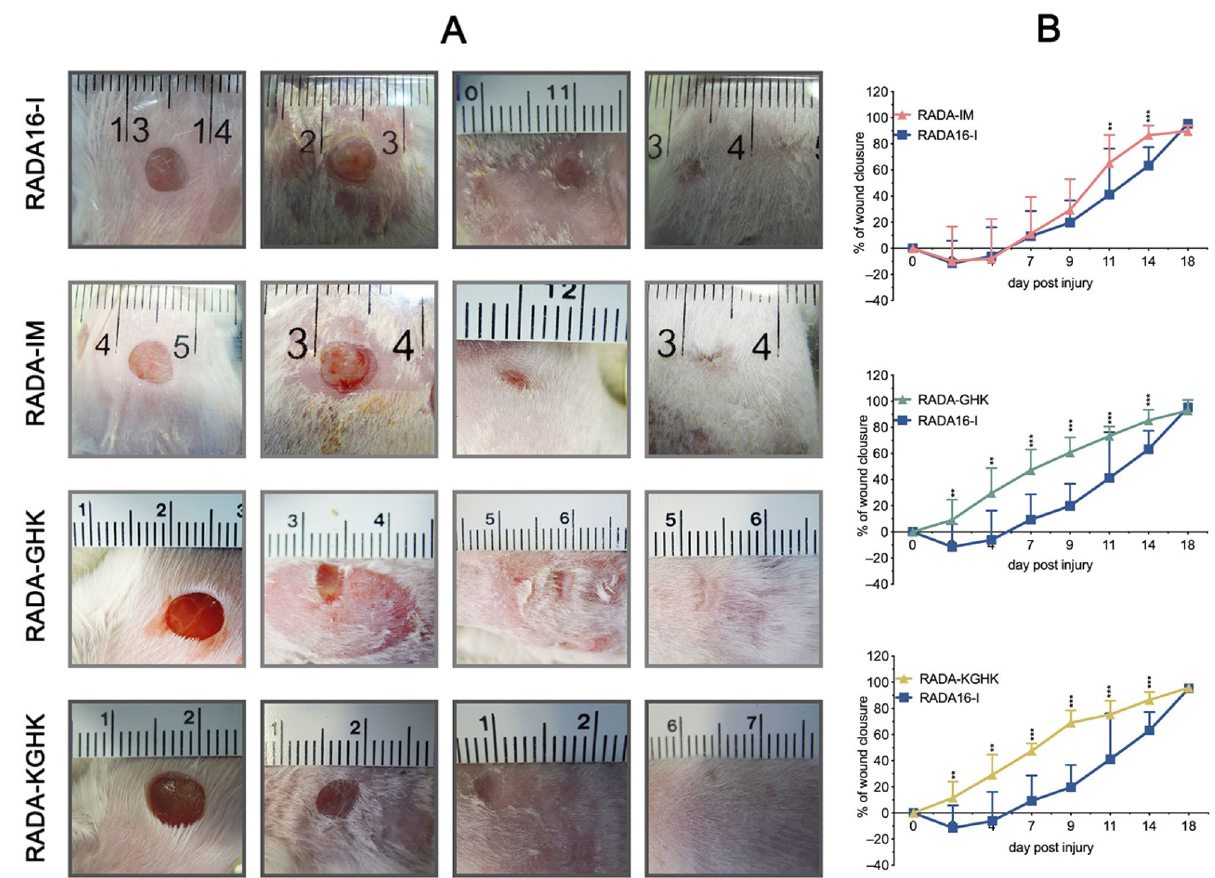
Figure 14. Skin healing process in wounds treated with RADA hybrid hydrogels contrasted with saline-treated controls. ( A ) representative photographs of the wound healing process on days 0, 7, 14, and 18 post-injury; ( B ) the mean area of wounds throughout the experiment; n = 6; error bars represent SD. Statistically significant differences compared to control were determined with the Mann–Whitney U test at p -value < 0.05. Significant p -values < 0.05, < 0.05, and 0.001 are marked with single “*”, double “**”, and triple asterisks “***”,